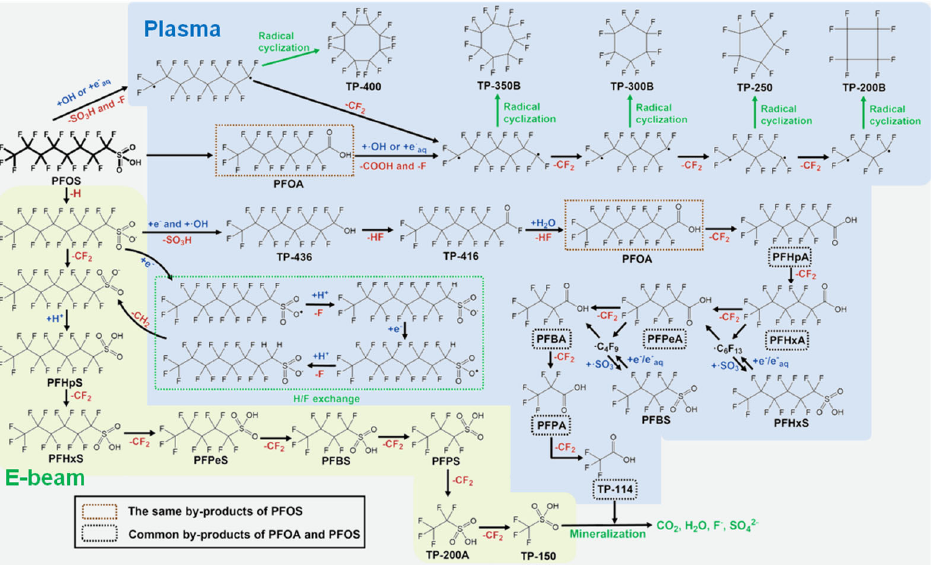
Figure 4 . Transformation pathways and reaction mechanisms of PFOS during the treatments using electron beam and plasma irradiation.